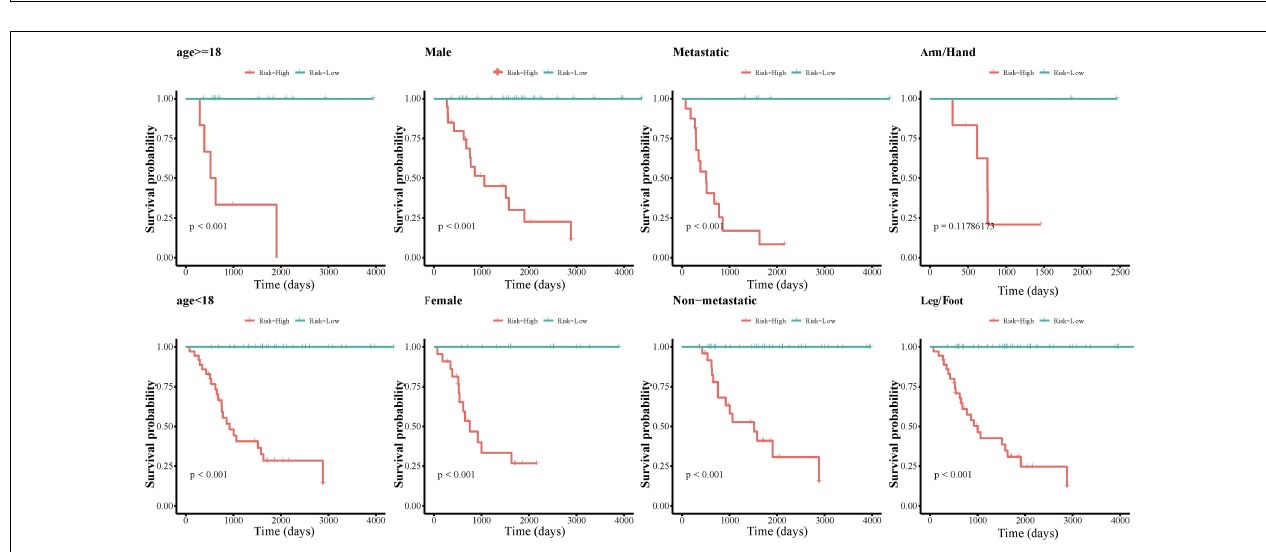
FIGURE 6 | ROC curves showing the prognostic value of the autophagy-related lncRNA signature and other prognostic biomarkers in osteosarcoma patients.